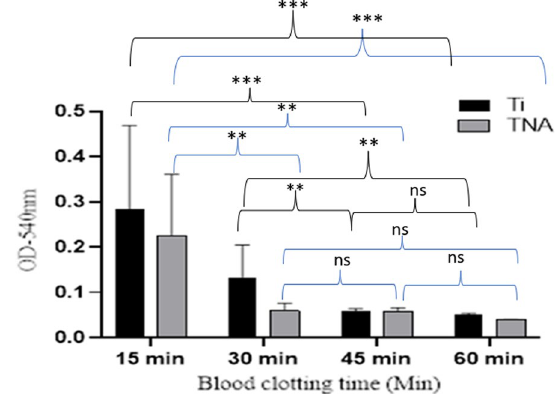
Fig. 5 Whole blood kinetic profile for Ti and TNA surfaces. The findings demonstrate that there is a significant difference between the material’s surface of Ti alloy and TNA nanosurface for times 15, 30, 45, and 60 min where the p -value is less than 0.05 when compared with minute of 15 with 30, 30 with 45 min for both Ti and TNA. The error bar reflects the mean standard deviation for three donors’ ±